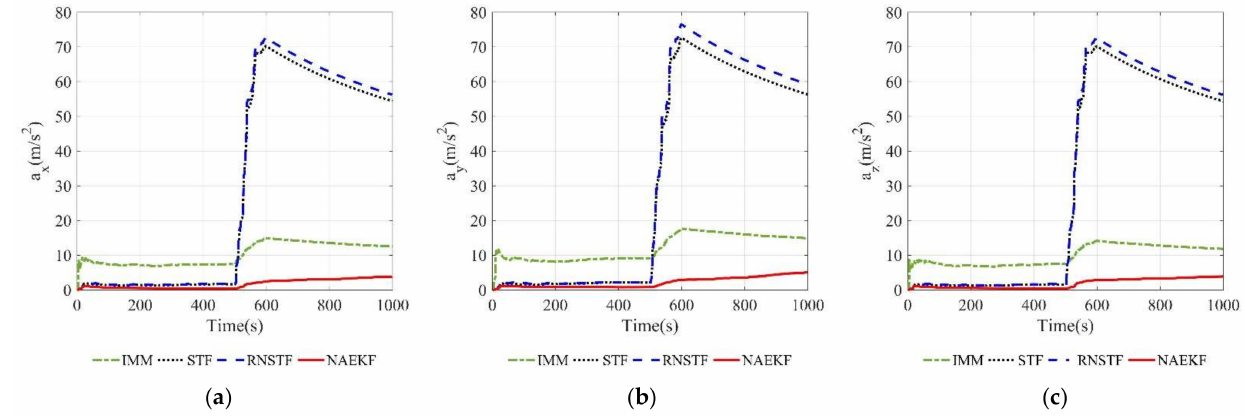
Figure 17. σ -Boundary of acceleration estimation errors. ( a ) σ -Boundary of a x ; ( b ) σ -Boundary of a y ; ( c ) σ -Boundary of a z .